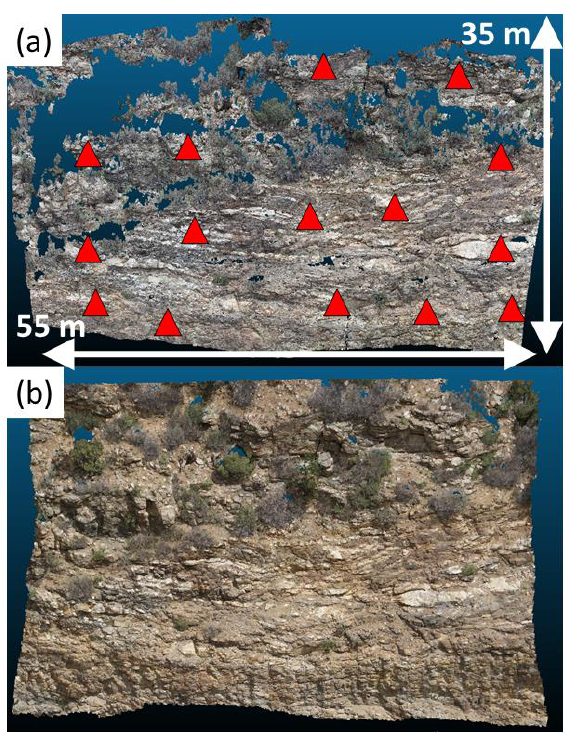
Figure 3. Study area and datasets for the Idaho